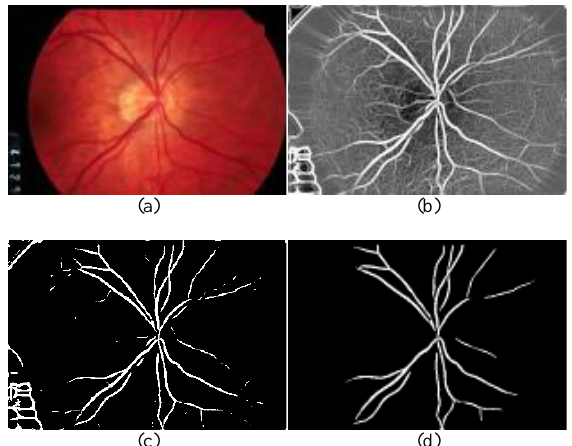
Figure 3. Results obtained in vessel segmentation phase. a) Original fundus image. b) Enhanced vessels using wavelet-based technique. c) Results of applying adaptive thresholding. d) Final detected main